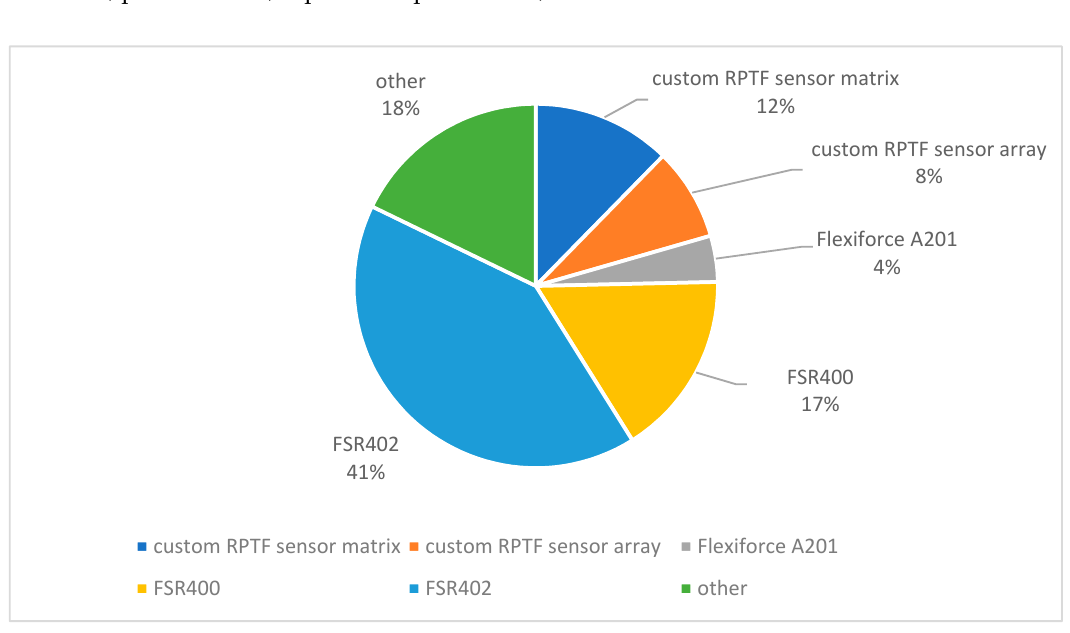
Figure 2. Percentage of the different FMG sensor types found in the literature ( n = 73).